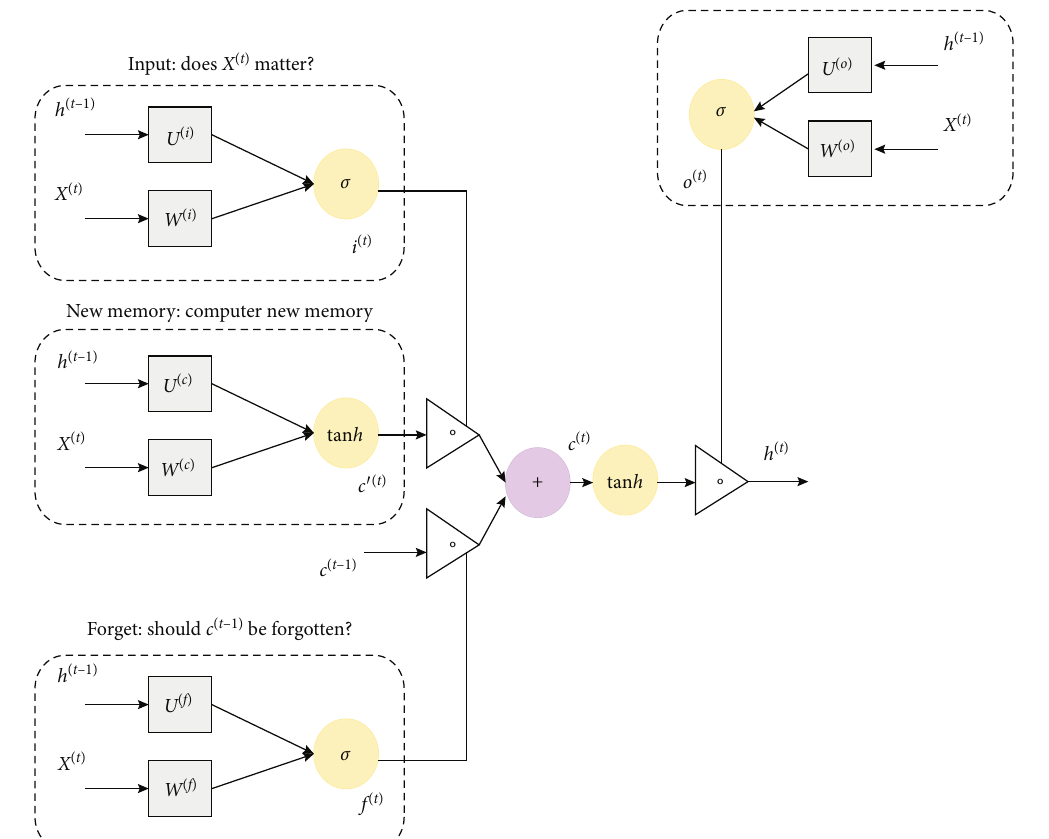
Figure 7: Generic structure of the long short-term memory (LSTM) model for the classification of Internet of Things (IoT)